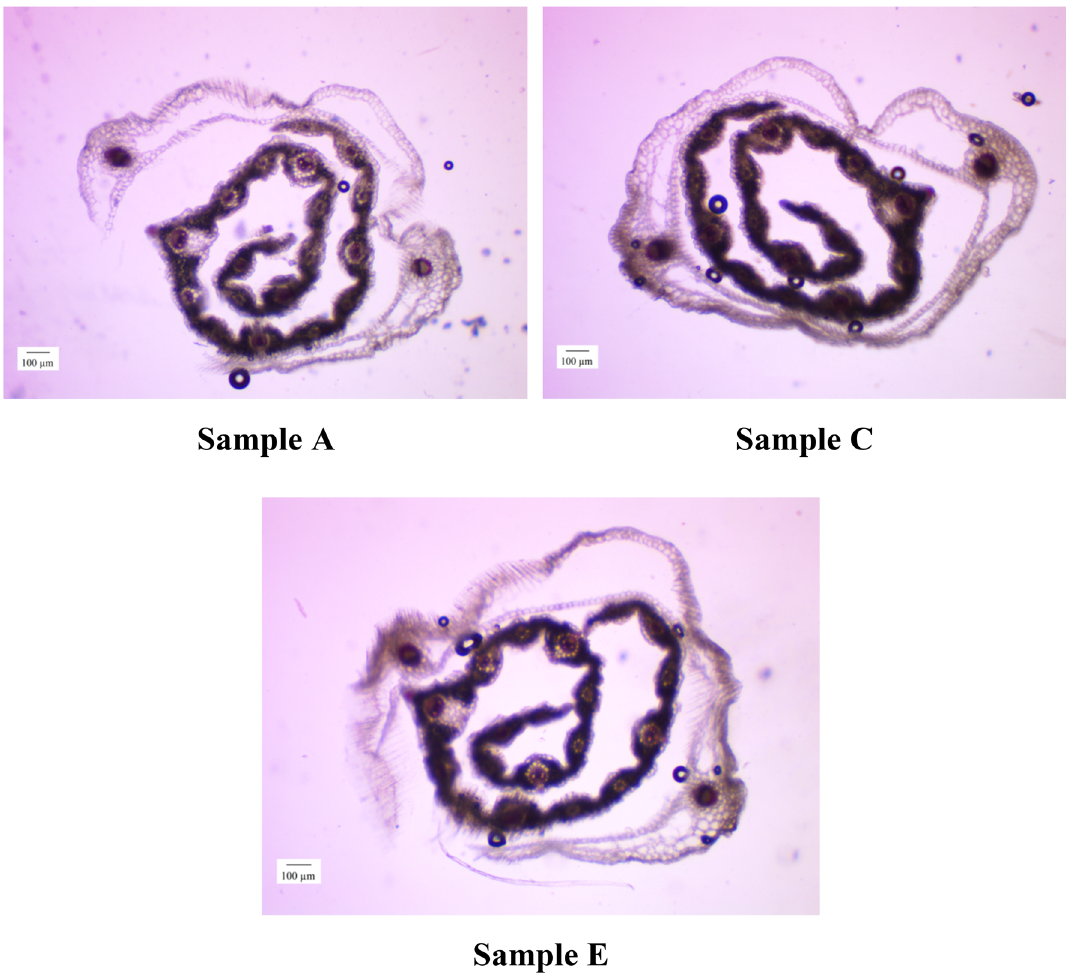
Figure 11. Typical 2D micrographs of the crosswise histological section of the seed sprout of Samples A, C and E at magnification cells are poorly colored; chlorenchyma is formed, but stained with low intensity. The sprout has a spiral tubular structure with a moderately pronounced supporting skeleton in the core. There is an intensive deposition of starch grains, which tend to swell and have a predominantly branched structure. Summarizing the data obtained, we can conclude that there was a more intensive use of endosperm reserve nutrients in Samples C and E. The optimal distribution of moisture concentration and the most intensive activa- tion of growth energy is determined in Sample C. Thus, the study of crosswise histological sections of the sprout of seed samples showed that 5 mg/L Se NPs contribute to the greatest intensity of seed germination. At the same time, no local destructions were detected in Sample E compared to Sample C, which indicates that the decrease in the effectiveness of Se NPs at concentrations > 5 mg/L is most likely due to inhibition of regulatory and catalytic processes in the germinating seed 89,90 . More detailed analysis of seed samples microstructure was carried out using µCT. We obtained 3D images of sprout and roots (Fig. 12), further processing of which made it possible to make cross sections with an assess- ment of geometric parameters and X-ray density (Fig. 13). Analysis of Fig. 12 showed that the average thickness of the roots was 508 µm in Sample A, 530 µm in Sample B, 541 µm in Sample C, 640 µm in Sample D and 487 µm in Sample E, which approximately corresponds to results of histological analysis. The greatest length of roots was observed in Sample C (12.7 mm), which also confirms